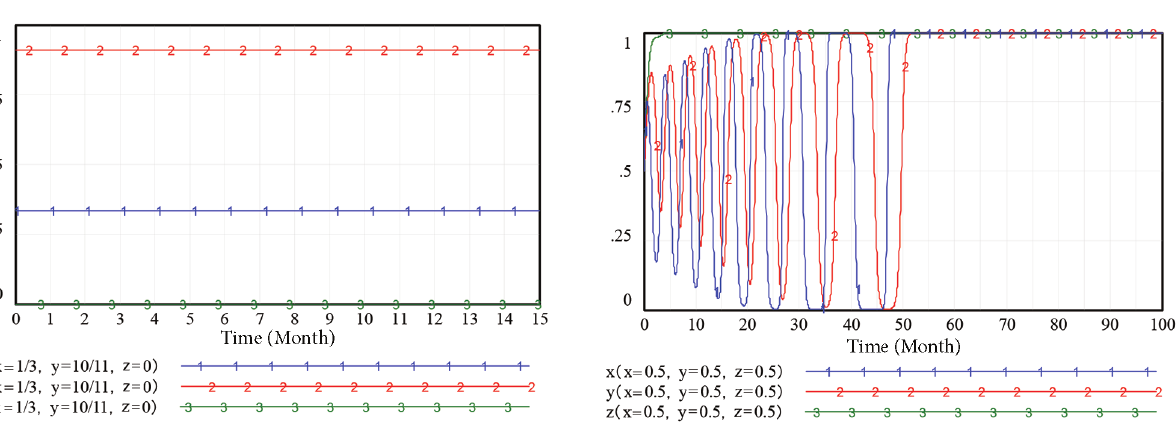
Figure 4. Game result under initial strategy λ 9